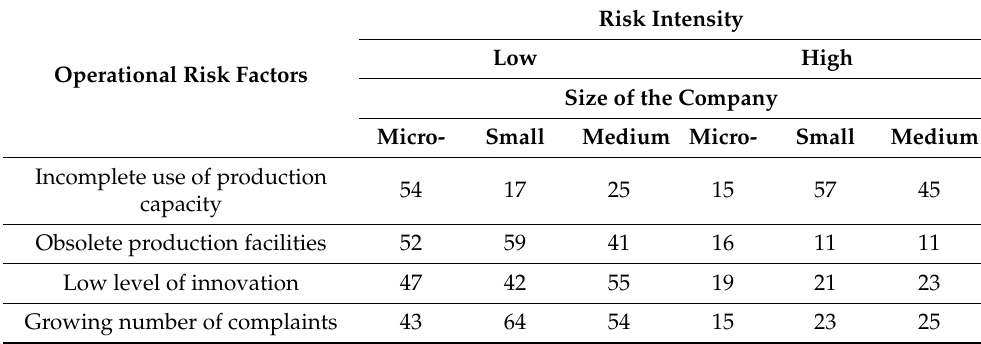
Growing number of complaints